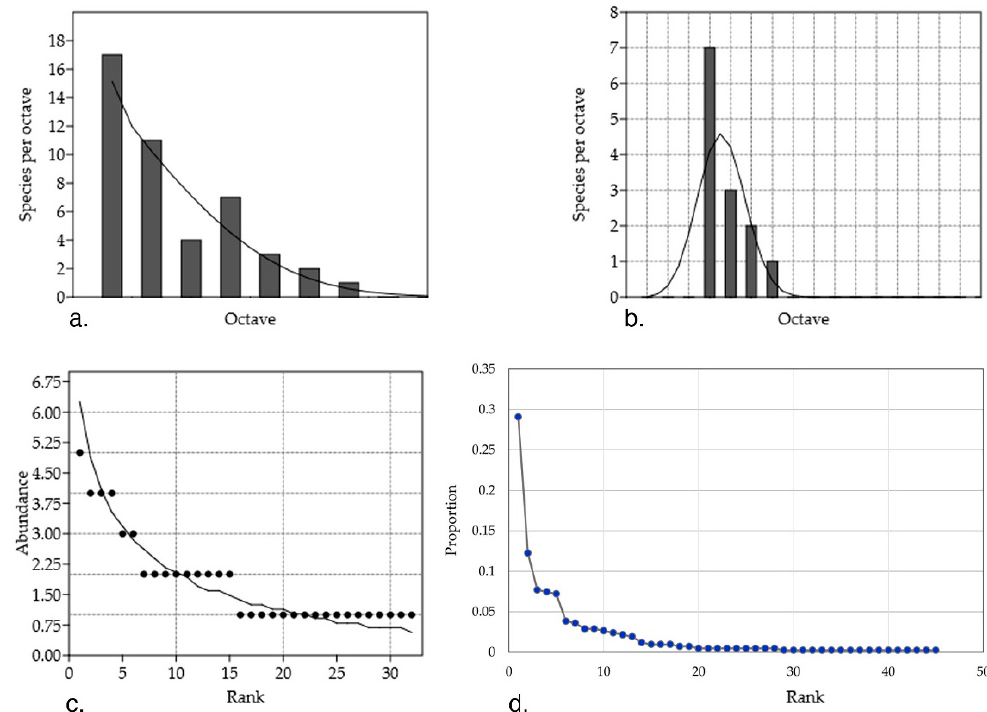
Figure 2. ( a ) The number of all endophytic fungi (EF) genera plotted in a log-normal distribution (fitted mean = 0.05, variance = 0.68, chi 2 = 2.81, p = 0.42) for different abundance octaves. The octaves refer to power-of-two abundance classes. The species which theoretically are expected to be present are veiled, as their low abundance prevents them for being represented in the sample. The log-normal distribution was a poor fit to this data due to an overabundance of rare species compared with that expected from the log-normal curve; ( b ) Abundant EF genera (> eight individuals) predicted by a log-normal distribution (mean = 1.28, variance = 0.12, chi 2 = 3.9, p = 0.04); a poor fit, as the first interval is dominated by a genus, namely Alternaria ; ( c ) Rare EF species (< eight individuals) predicted by a log series distribution ( α = 29.32, x = 0.66, chi 2 = 0.72, p = 0.99), where many rare genera (17 genera with one strain) are represented by a jagged line because predicted values are rounded to the nearest number; ( d ) Rank abundance curve of the endophytic fungal genera. The slope is extremely steep at the beginning at the curve, meaning that evenness of the community is low, where few of the genera are highly abundant. For ( a – c ), only absolute counts, as opposed to relative proportions, were